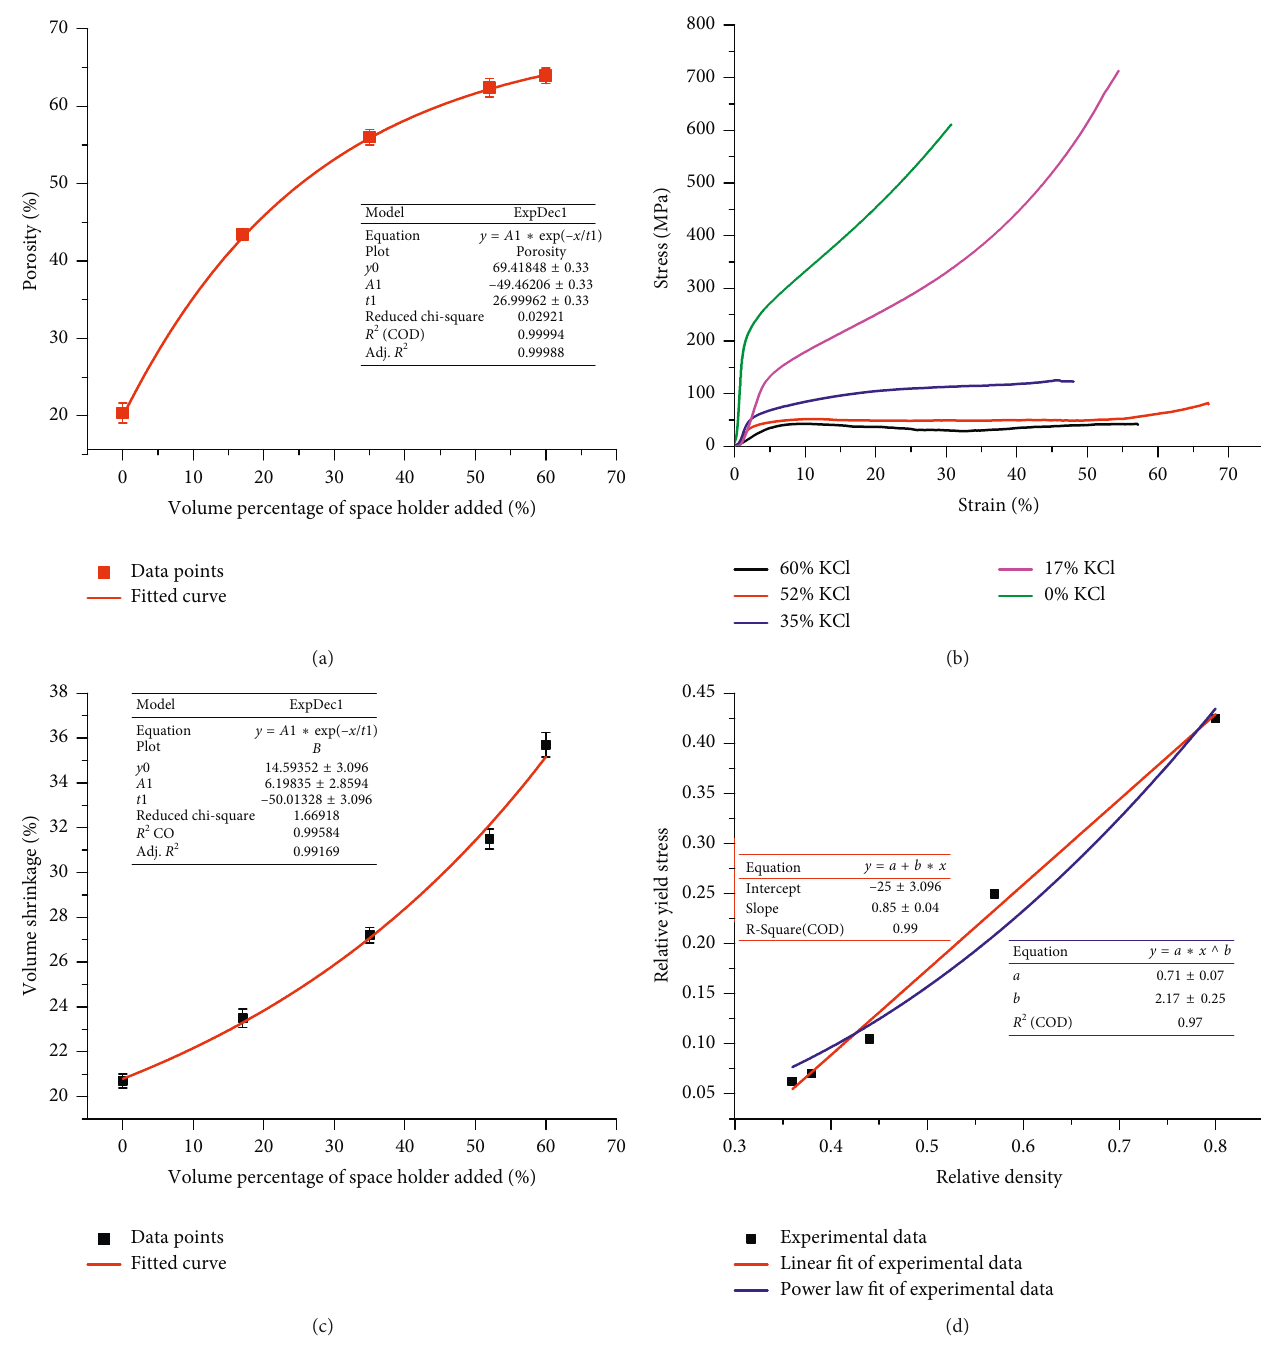
Figure 6: (a) The relationship between the amount of space holder added and the final percentage of porosity in the sintered samples; (b) mechanical strength of samples with different amounts of porosity under compression; (c) the relationship between the amount of space holder added and the volume shrinkage of samples after sintering; (d) the change in the relative yield stress with the change in the relative density with two fitted curves, namely, linear and power